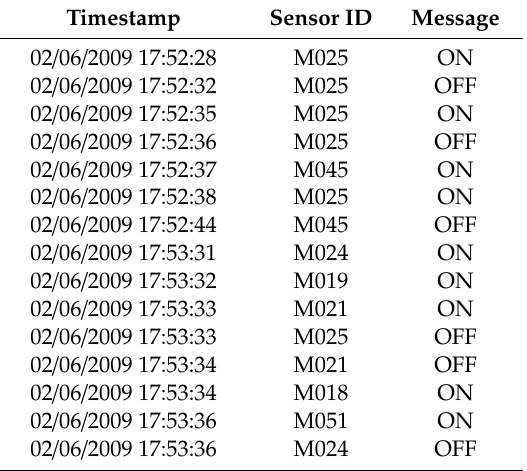
Table 1. An example of sensor messages recorded from the on-campus smart home testbed. Each sensor message contains the message date/time, the sensor ID, and the sensor message.